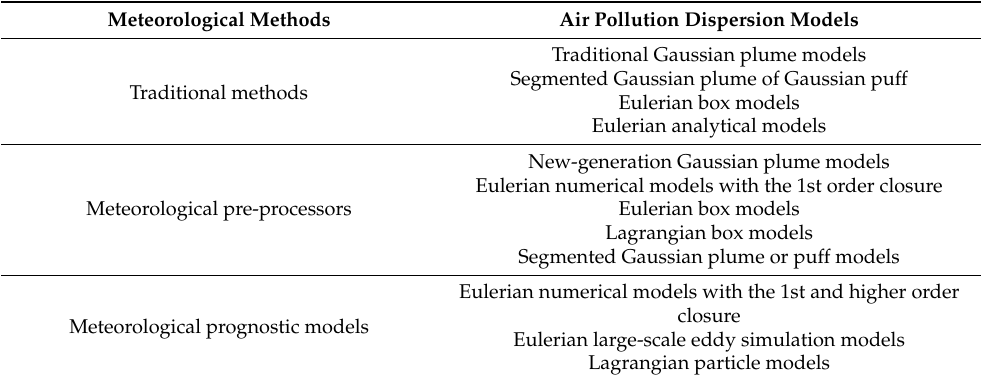
Table 2. Relationships between meteorological methods to determine meteorological data and air pollution dispersion models